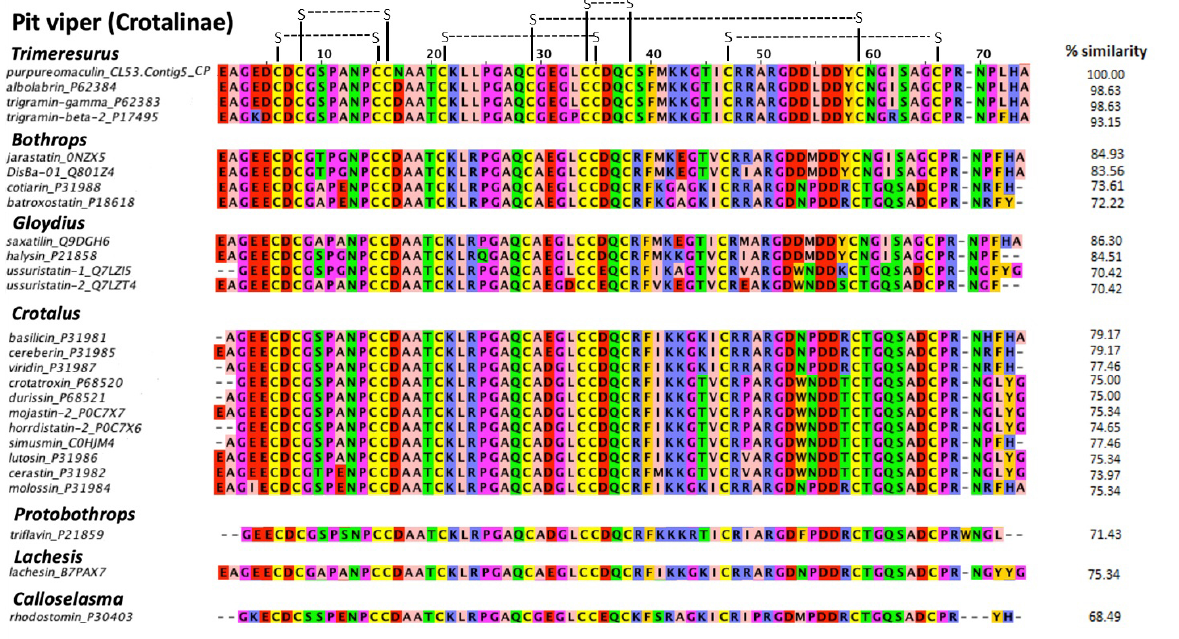
Figure 6. Multiple sequence alignment of purpureomaculin (CL53.Contig5_CP) with other disintegrin sequences of Crotalinae. Purpureomaculin is a disintegrin isolated from the Malaysian Trimeresurus purpureomaculatus venom, while other disintegrin sequences were obtained from UniProtKB. The percentages of similarity (% similarity) of disintegrin sequences in comparison to purpureomaculin were calculated using Omega Clustal software. Zappo color scheme indicates residue properties: pink: aliphatic/hydrophobic; orange: aromatic; blue: positive; red: negative; green: hydrophilic; magenta: proline/glycine (conformationally special); yellow: cysteine. Disulfide bonds were illustrated in black connecting